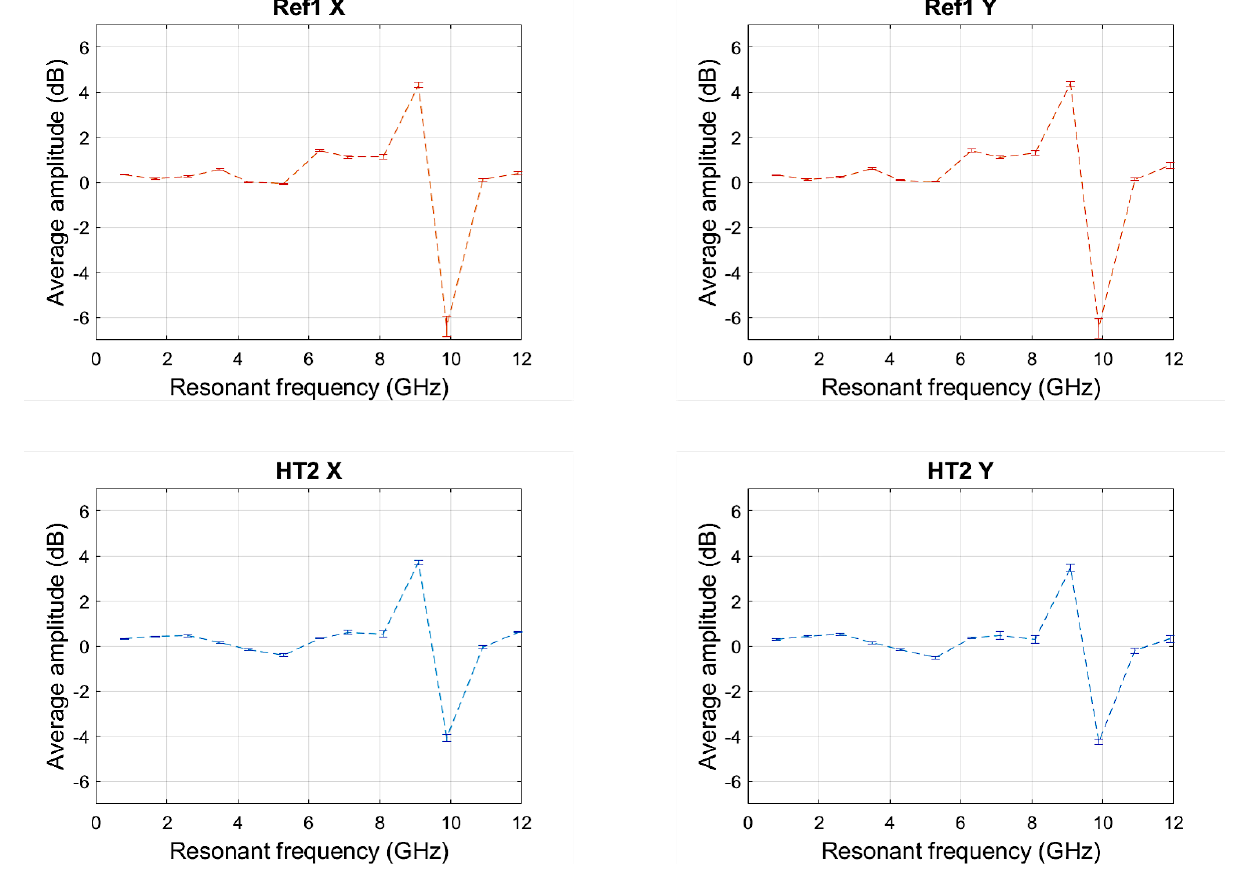
Figure 4. Averaged amplitude of SMM signal against